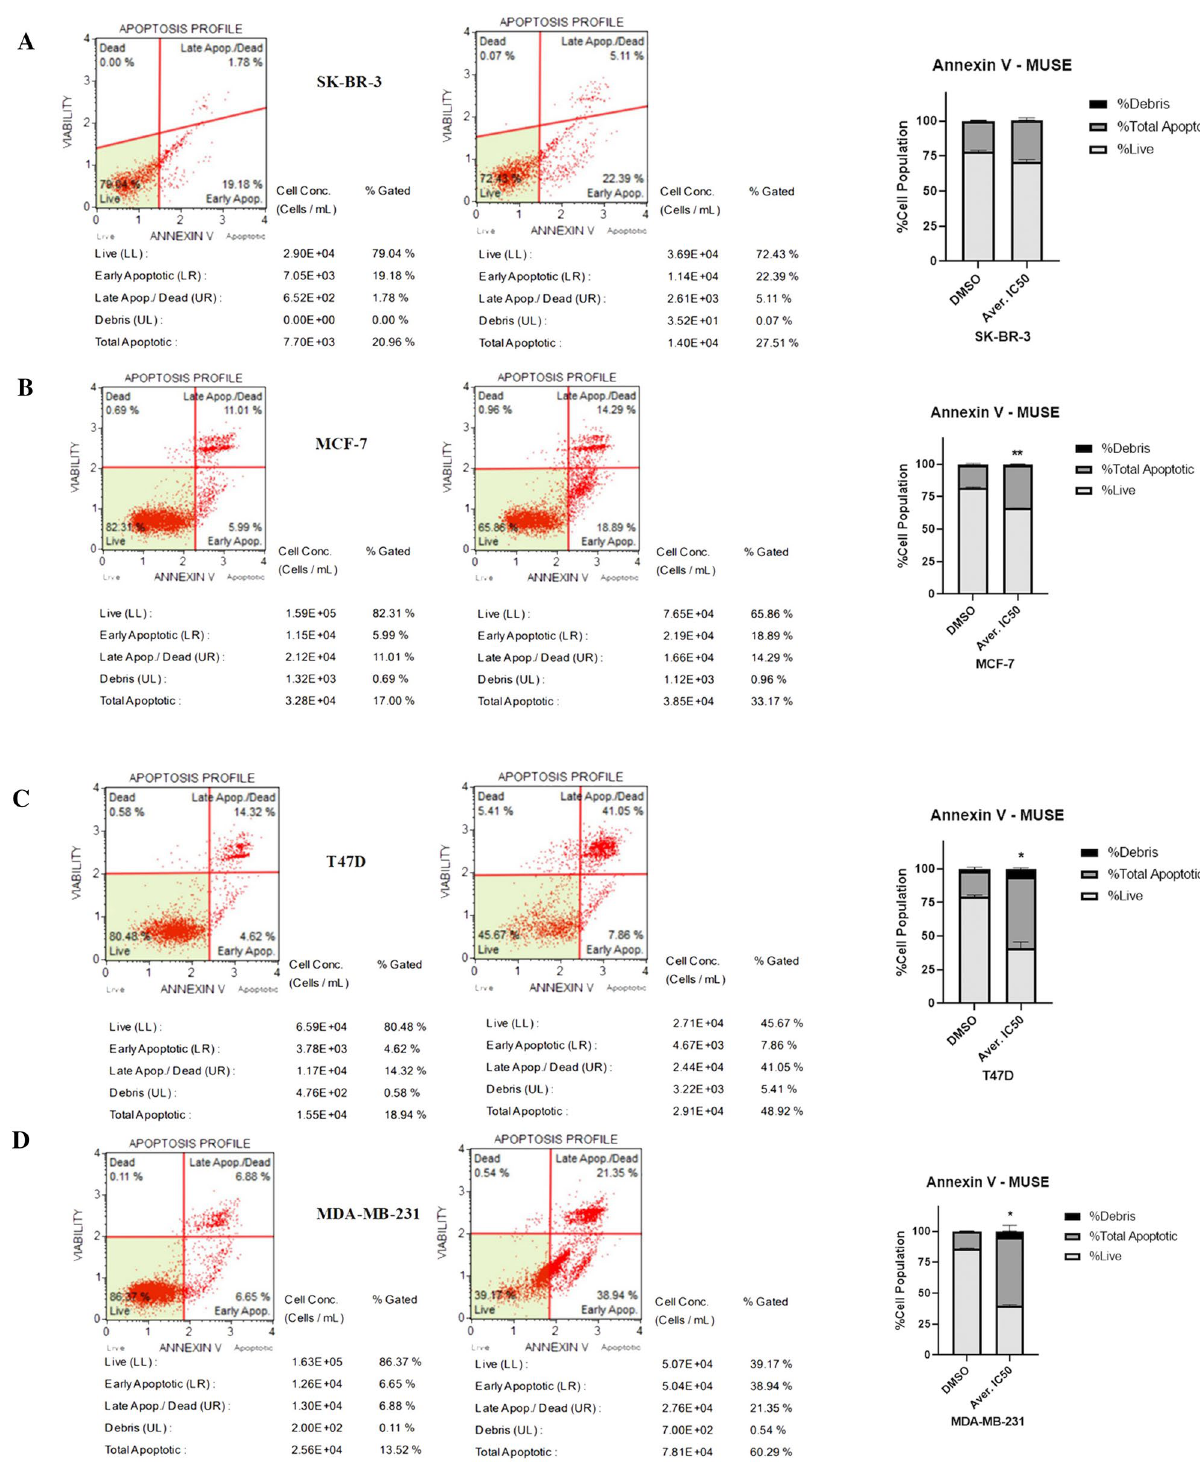
Figure 4. Averufanin induced accumulation of early and late apoptotic cells. The effects of Averufanin (IC 75 ) treatment (right lane) on cancer cell lines ( A ) SK-BR-3, ( B ) MCF-7, ( C ) T47D, ( D ) MDA-MB-231 compared to DMSO negative control (left lane) for 72 h were investigated with MUSE Cell Analyzer using Annexin V & Dead Cell program and kit. Representative flow cytometry plots are shown. 10.000 cells were scored in each analysis. % cells in each quadrant are indicated on the plots. Treatment of each cell line resulted in a significant increase in the total apoptotic number of cells, majorly late apoptotic in T47D and majorly early apoptotic in MCF7. The results of Annexin V Assay suggested that Averufanin induced apoptosis in all three breast cancer cell lines. Significantly difference compared to DMSO treated cells (***p < 0.001, p < 0.01, p <